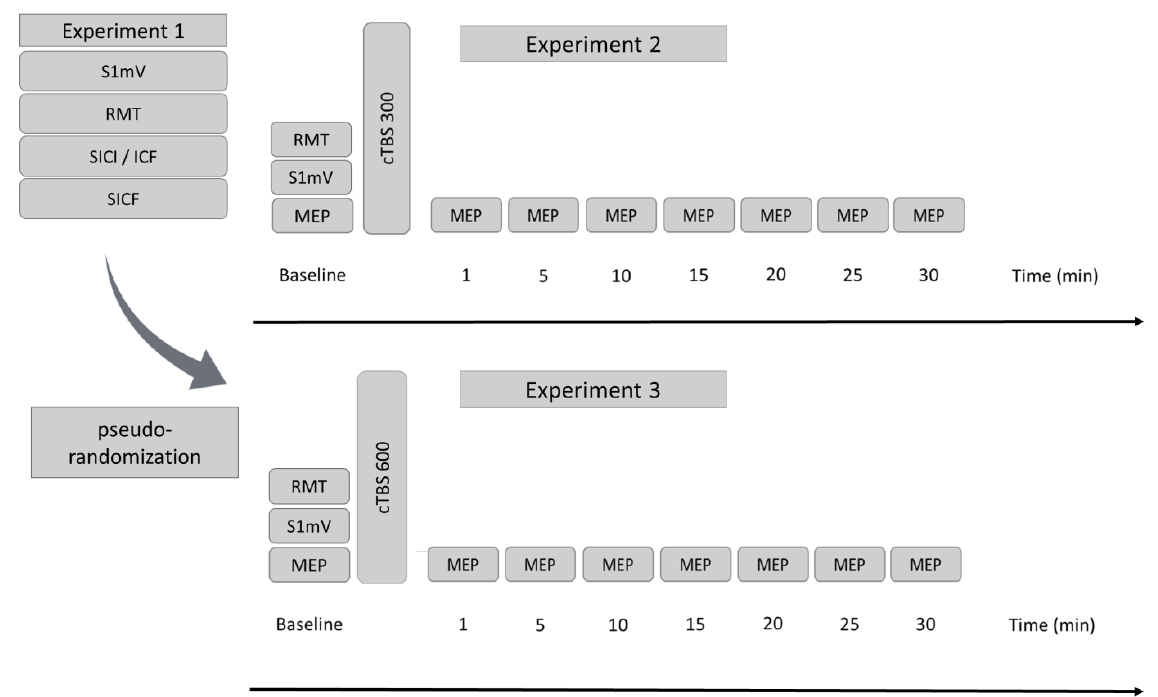
Figure 1. Study flowchart. Experiment 1 ( left ): S1 mV: intensity to evoke MEP of approximately 1 mV, RMT: resting motor threshold, SICI/ICF: short-intracortical inhibition/intracortical facilitation, SICF: short-interval intracortical facilitation. Experiment 2 ( upper right ): MEP: motor-evoked potentials. cTBS 300: continuous theta-burst stimulation for a duration of 20 s. Experiment 3 ( lower right ): MEP: motor-evoked potentials. cTBS 600: continuous theta-burst stimulation for a duration of 40 s. Time bins are reported in minutes. In Experiment 1, all measures (MEP, S1 mV, and RMT) were acquired using a monophasic stimulator. In Experiment 2 and Experiment 3, MEP and S1 mV were obtained using a monophasic stimulator for excitability monitoring, while RMT and a second S1 mV were acquired with a biphasic stimulator.